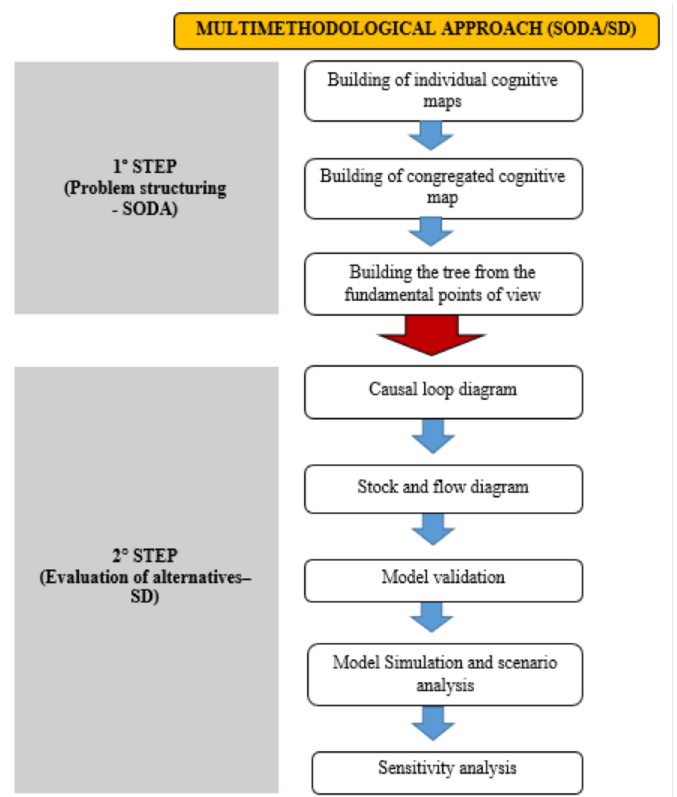
Figure 4. Step-by-step application of the SODA/SD